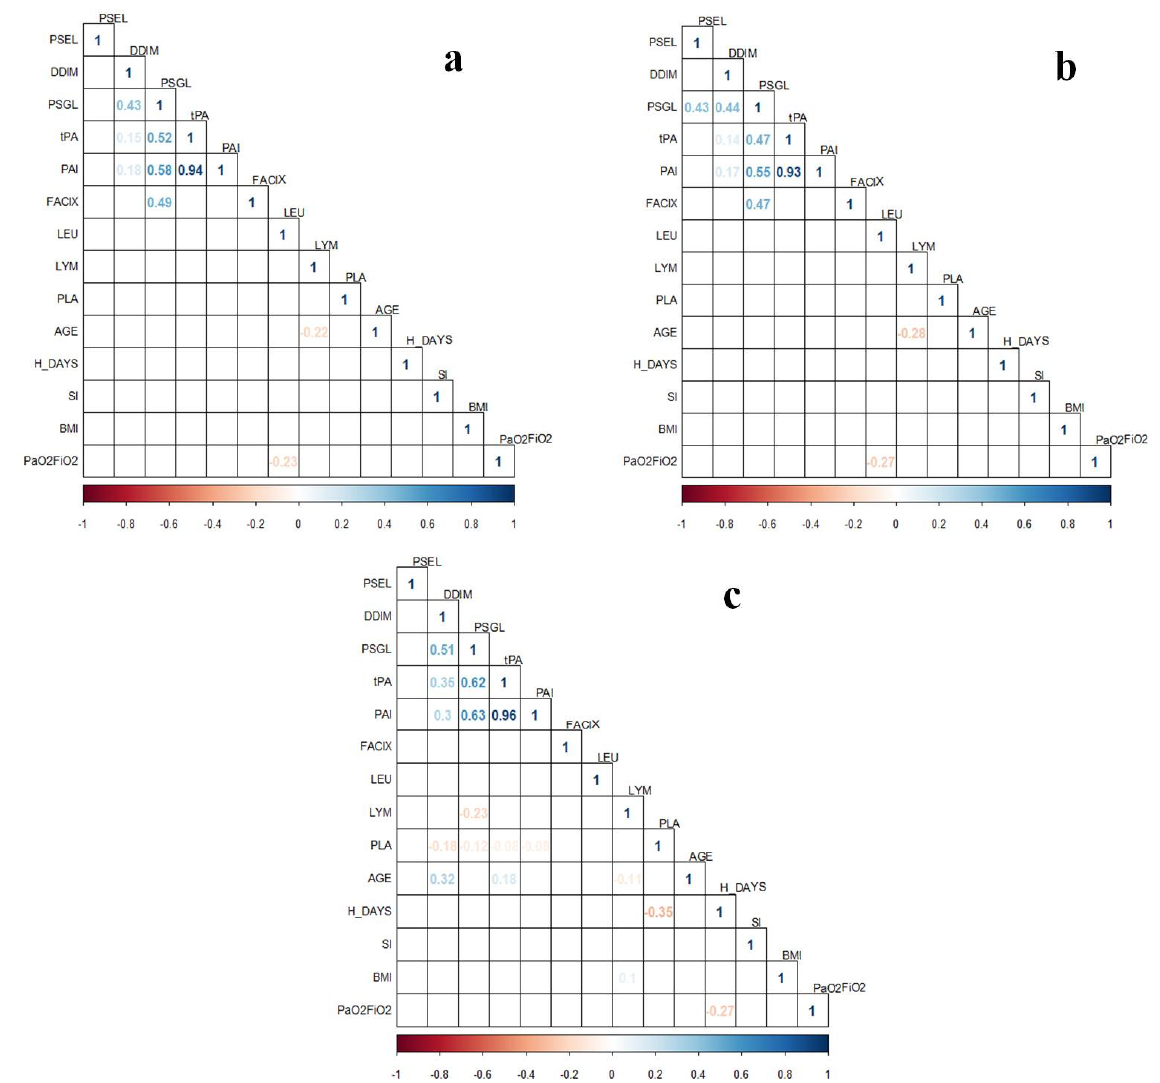
Figure 2. Correlation plots of coagulation proteins’ levels from one-time determination subgroup ( n = 131) with clinical variables in patients with COVID-19. ( a ) Analysis including all samples of the one-time determination subgroup ( n = 131); ( b ) Analysis only including patients carrying the SERPINE1 rs6092 GG genotype ( n = 92); ( c ) Analysis only including patients carrying the SERPINE1 rs6092 AG+AA genotypes ( n = 39). Correlations were assessed with Spearman Correlation Test. Only statistically significant ρ values ( p < 0.05) are shown in the plots. BMI, body mass index; FACIX, Factor IX; DDIM, D-dimer; H_DAYS, hospitalization days; LEU, leukocytes; LYM, lymphocytes; PAI, plasminogen activator inhibitor-1; PLA, platelets; PSGL, P-selectin glycoprotein ligand-1; PSEL, P-selectin; SI, smoking index; tPA, tissue plasminogen